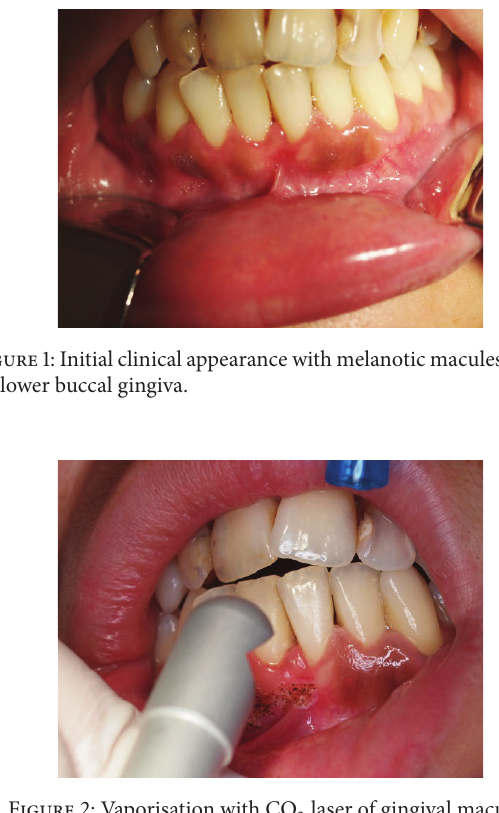
Figure 2: Vaporisation with CO 2 laser of gingival